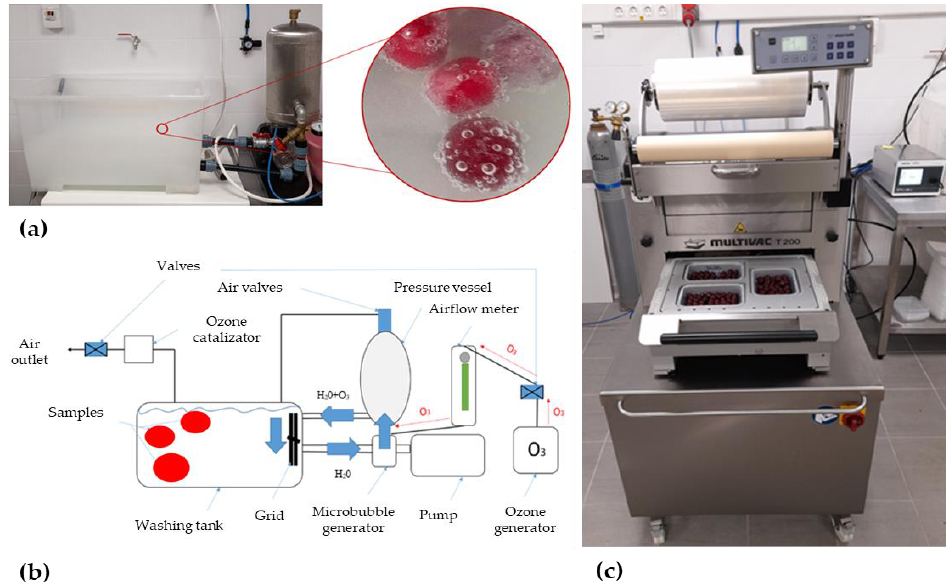
Figure 1. Washing of sour cherry with ozone microbubbles ( a ); Technical diagram of ozone washing ( b ); Sour cherry modified atmosphere packaging in progress ( c